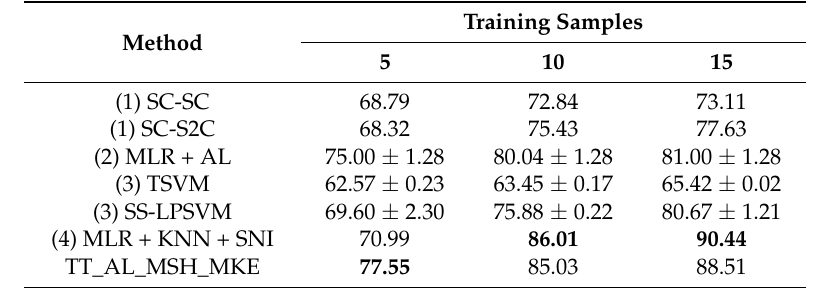
Table 8. Comparison of the methods, denoted as TT_AL_MSH_MKE, with the results reported in table are marked in bold italics. SC-SC, semi-supervised classification algorithm based on spectral cluster; TSVM, transductive support vector machine; SS-LPSVM, spatial-spectral label propagation based on the support vector machine.